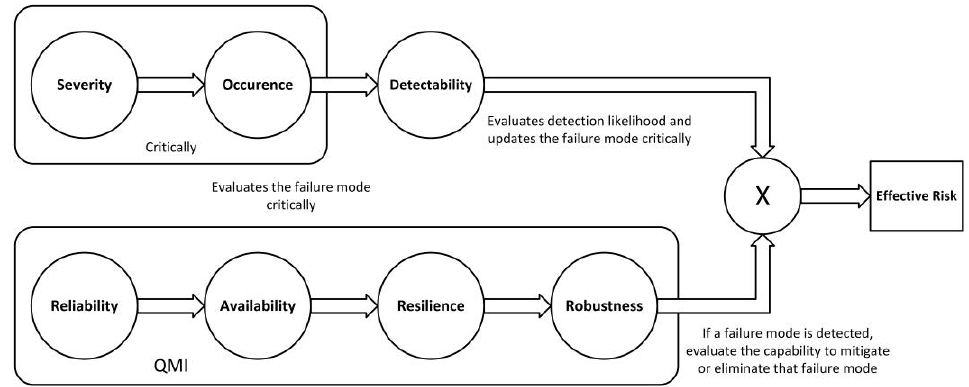
Figure 2. Effective risk model framework.